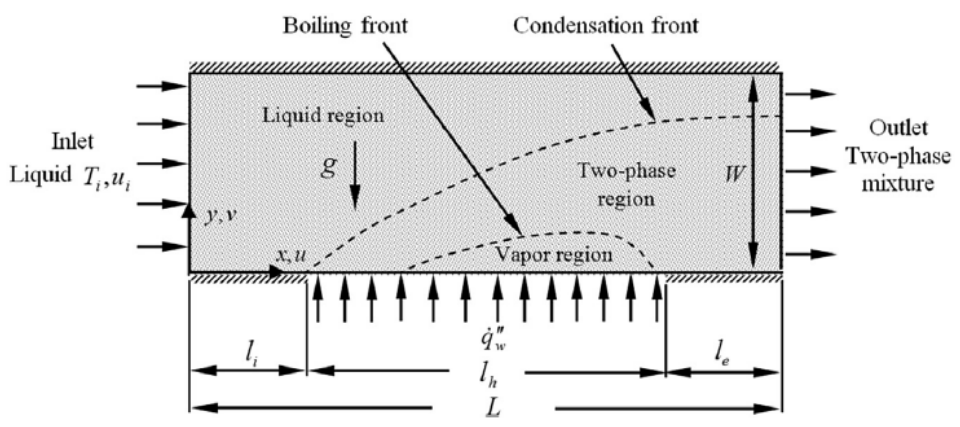
Figure 28. The phase change problem in a porous medium considered by Alomar et al. [52]. Hassanpour and Saboonchi [53] performed another comparative study using both the LTE and LTNE models to investigate the validity of the LTE for a blood flow throughout a vascular tissue-like porous medium, illustrated in Figure 29, during a perivascular hyperthermia situation, for two counter- and co-current vascular networks.